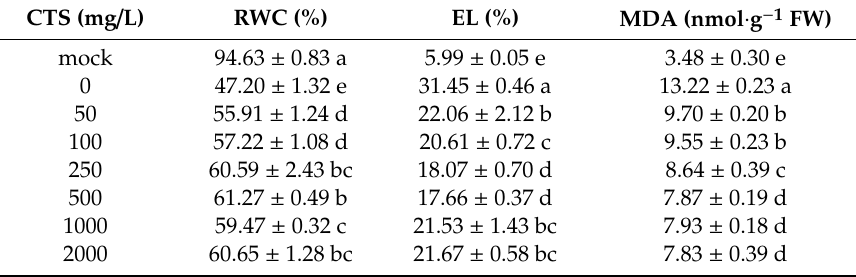
Table 2. The e ff ect of di ff erent concentrations of CTS on relative water content (RWC), leaf electrolyte leakage (EL), and malondialdehyde (MDA) content in leaves of annual ryegrass under 4 days of water stress